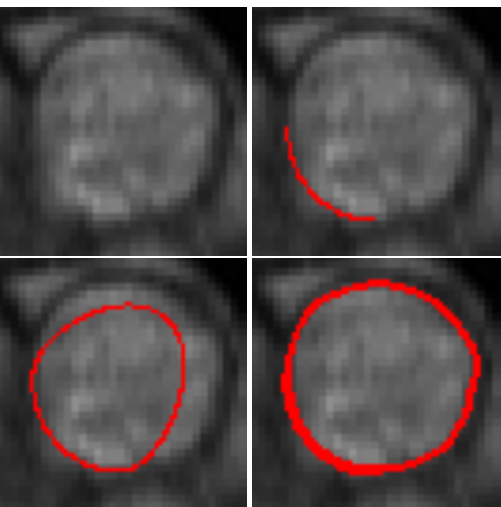
Figure 10. Blood vessel image, user-defined constraint ( top right ), initial contour ( bottom left ) and final ( bottom right ) contours. Let us note that we have successfully segmented the complete image